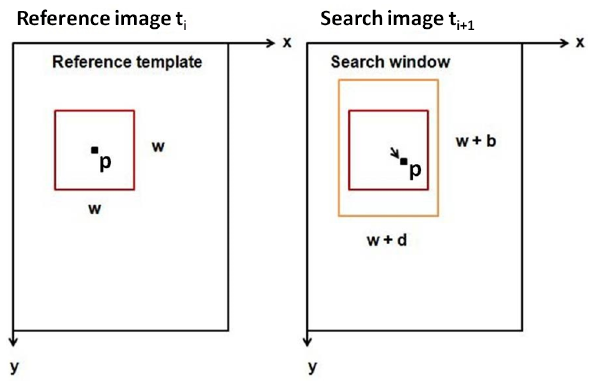
Figure 1: Scheme of the image pairs together with the reference template, the central pixel and the search